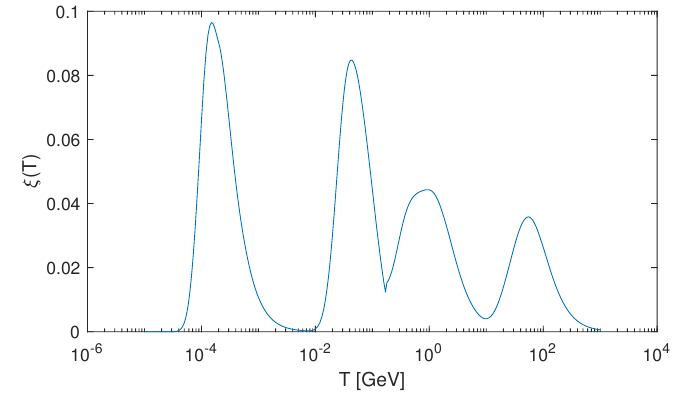
Figure 5 . The plot of (cid:24) ( T ) = (cid:0) T (cid:22)